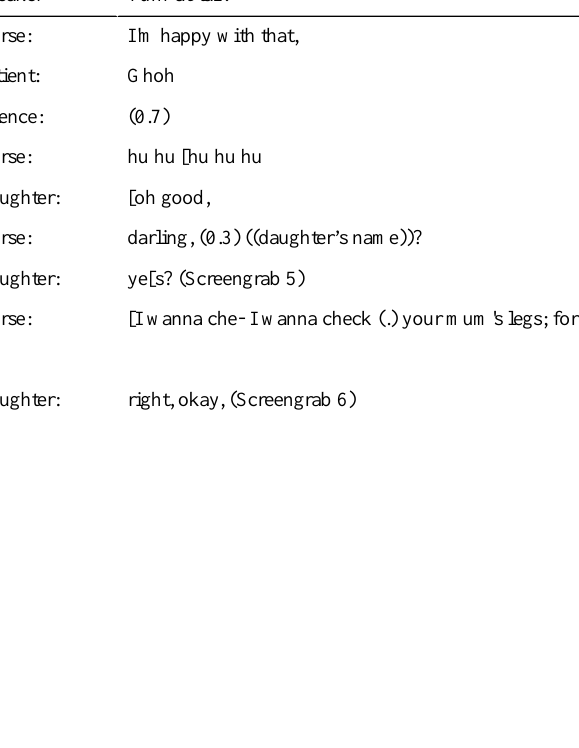
Table 4. Example of a nurse involving a relative into a video consultation (data recorded at the patient end).